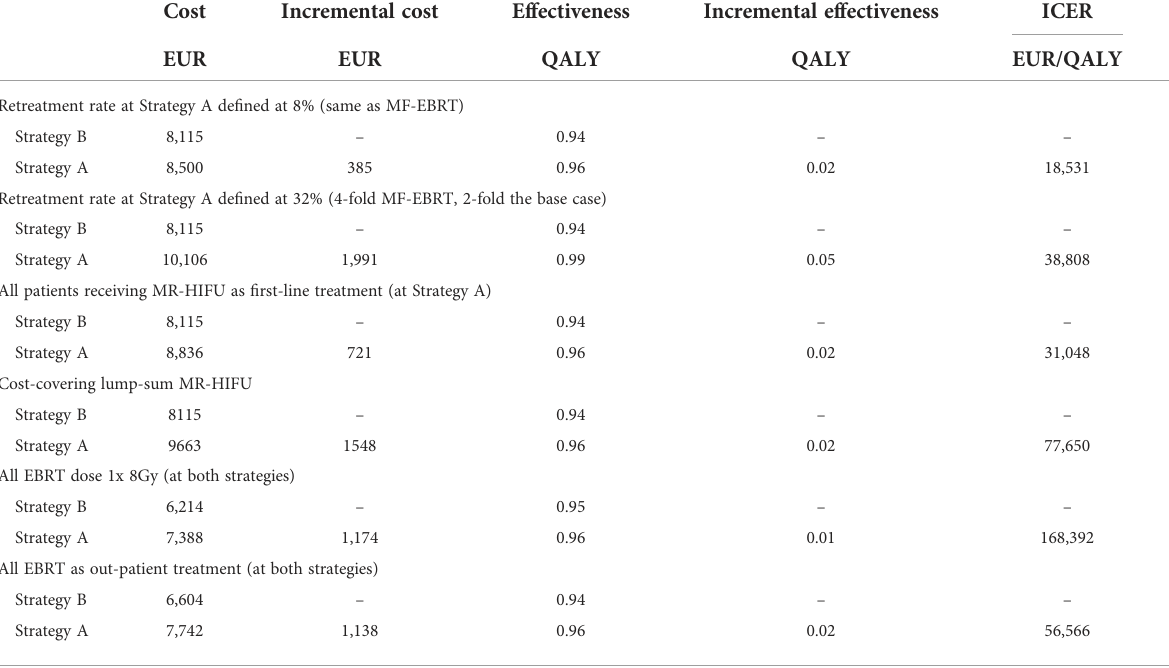
TABLE 3 Structural sensitivity analyses results.